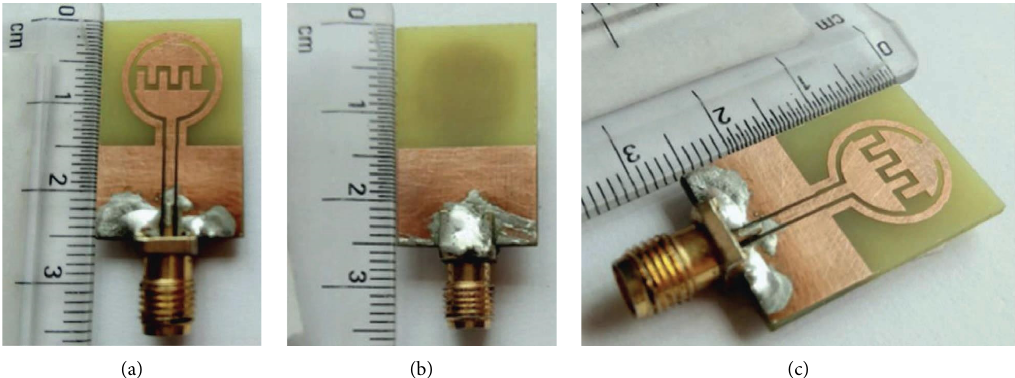
Figure 7: Photograph of proposed dual-band MTM antenna: (a) top view, (b) ground plane, and (c) 3D view.